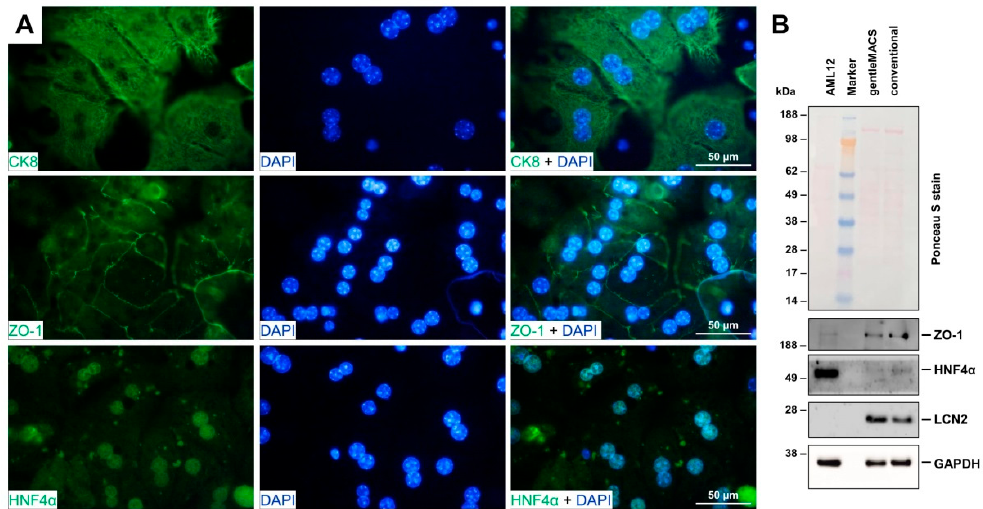
Figure 5. Marker protein expression in hepatocytes. ( A ) Primary hepatocytes were isolated with the gentleMACS Perfusion Technology and subjected to fluorescence immunostaining using rabbit monoclonal anti-cytokeratin 8 (CK8) (#ab53280, Abcam, Berlin, Germany), polyclonal rabbit anti-Zonula occludens-1 (ZO-1) (#85047, Novus Biologicals, Wiesbaden-Nordenstadt, Germany), and polyclonal goat hepatocyte nuclear factor 4 α (HNF4 α ) (#sc-6556, Santa Cruz Biotech., Santa Cruz, CA, USA) for staining. Nuclei were counterstained with 4 ′ ,6-diamidino-2-phenylindole (DAPI, Sigma-Aldrich, Taufkirchen, Germany) and images were taken at 1000× magnification using a Leica DMRB fluorescence microscope (Leica, Wetzlar, Germany) equipped with a Nikon Coolpix 5400 camera (Nikon Germany, Düsseldorf, Germany). Brightness and contrast were adjusted for clarity without changing the content. ( B ) Protein extracts from hepatocytes isolated with the gentleMACS Perfusion Technology or conventional isolation procedure were tested using Western blot analysis for expression of ZO-1 (#40-2300, ThermoFisher), HNF4 α (#sc-6556, Santa Cruz Biotech.), Lipocalin 2 (LCN2) (#AF3508, R&D Systems, Wiesbaden, Germany) and Glyceraldehyde-3-phosphate dehydrogenase (GAPDH) (#sc-32233, Santa Cruz). The mouse hepatocyte cell line AML12 was taken as a positive control for expression of ZO-1 and HNF4 α .